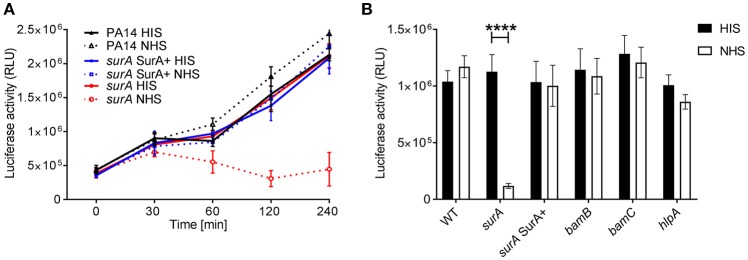
SurA deletion leads to increased serum sensitivity. Indicated bacterial strains were grown for (A) various time periods or (B) 2 h and subsequently, luciferase activity (which is directly proportional to the ATP levels of viable cells in a sample) was measured. Data depict the mean and SD of luciferase activity measured of 3 independent experiments performed in triplicates. Asterisks indicate significant differences (p < 0.0001) analyzed by one way ANOVA analysis.